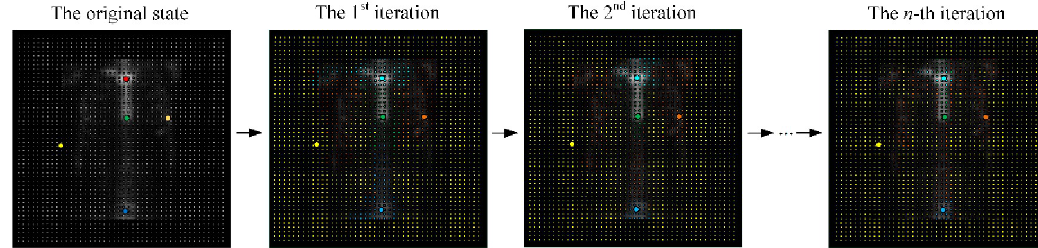
Fig 9. An example of K -means clustering based hotspot segmentation with thorax bone SPECT image with K = 5.